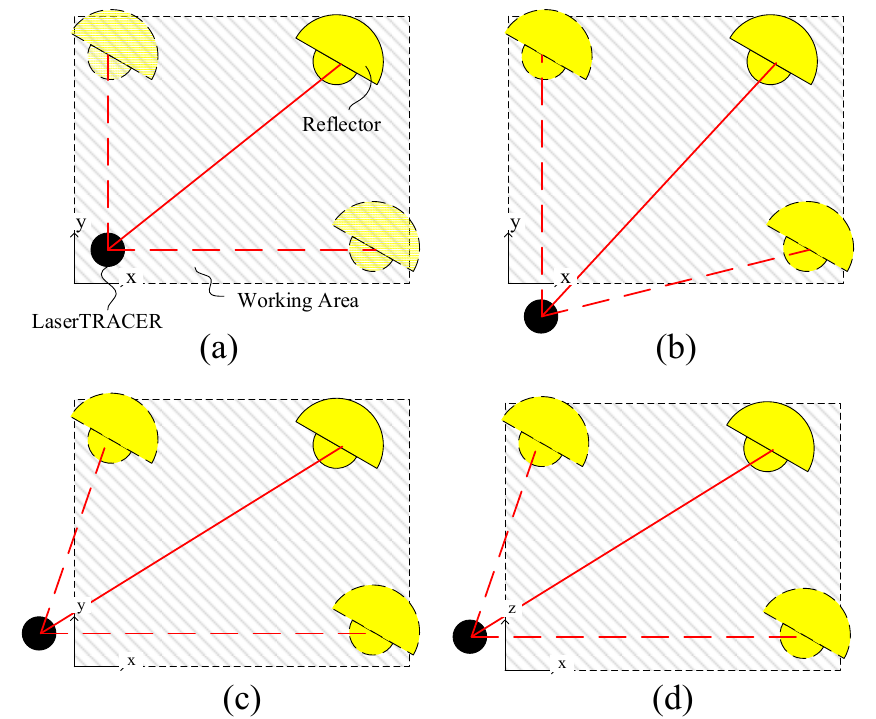
Figure 9. The ATLI must be placed inside the working area of machine tools: ( a ) the ATLI placed inside the working area ( xy plane view); ( b ) when ATLI placed outside of the working area in y ‐ direction ( xy plane view); ( c ) the ATLI placed outside of the working area in x ‐ direction ( xy plane view); and ( d ) the ATLI placed outside of the working area in x ‐ direction ( xz plane view).